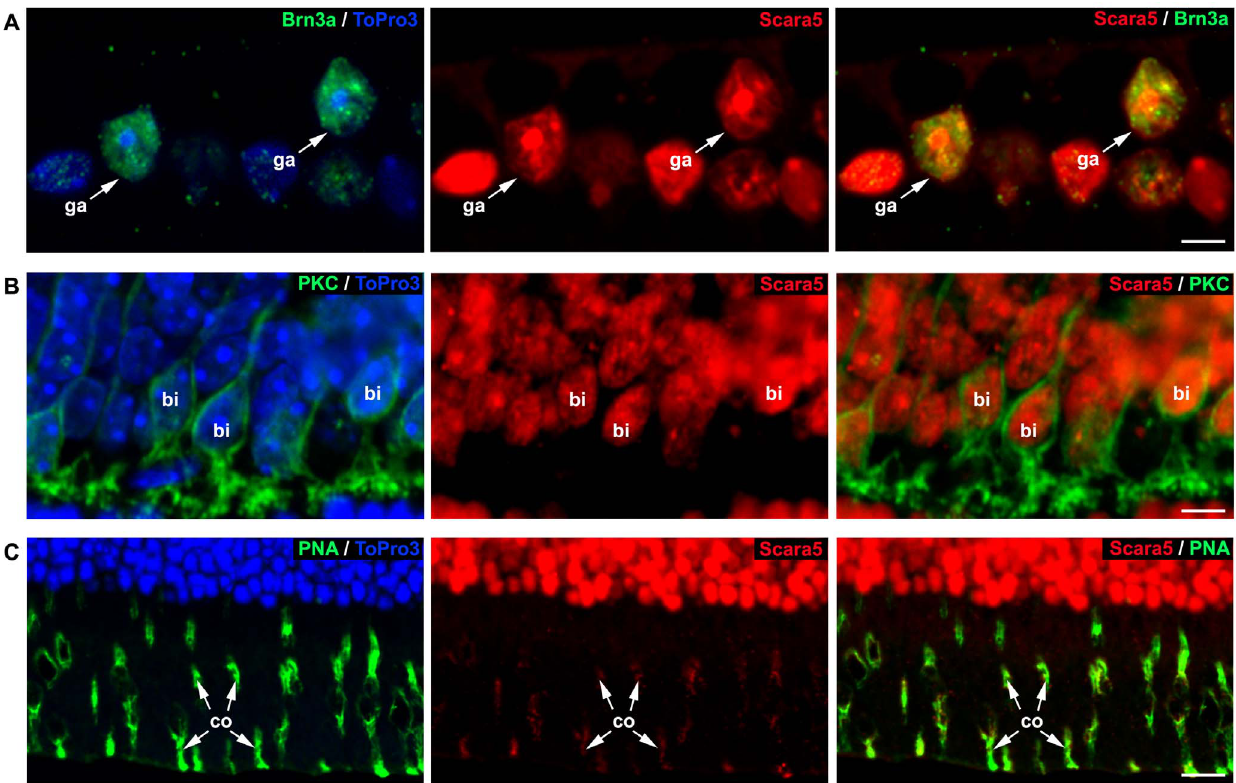
Figure 3. Scara5 was expressed in retinal neurons. A: Labeled retinal ganglion cells with Brn3a showed a nuclear intense Scara5 signal. B: PKC positive bipolar cells expressed Scara5. C: Photoreceptors presented a high expression of Scara5. The labeling with PNA lectin, which is specific for cone inner segments, showed a more intense signal in cones than in rods. Nuclei were counterstained with ToPro3. ga, retinal ganglion cells; bi, bipolar cells; co, cone inner segments. Scale bars: 3,8 m m (A); 5,4 m m (B); 12,5 m m (C).